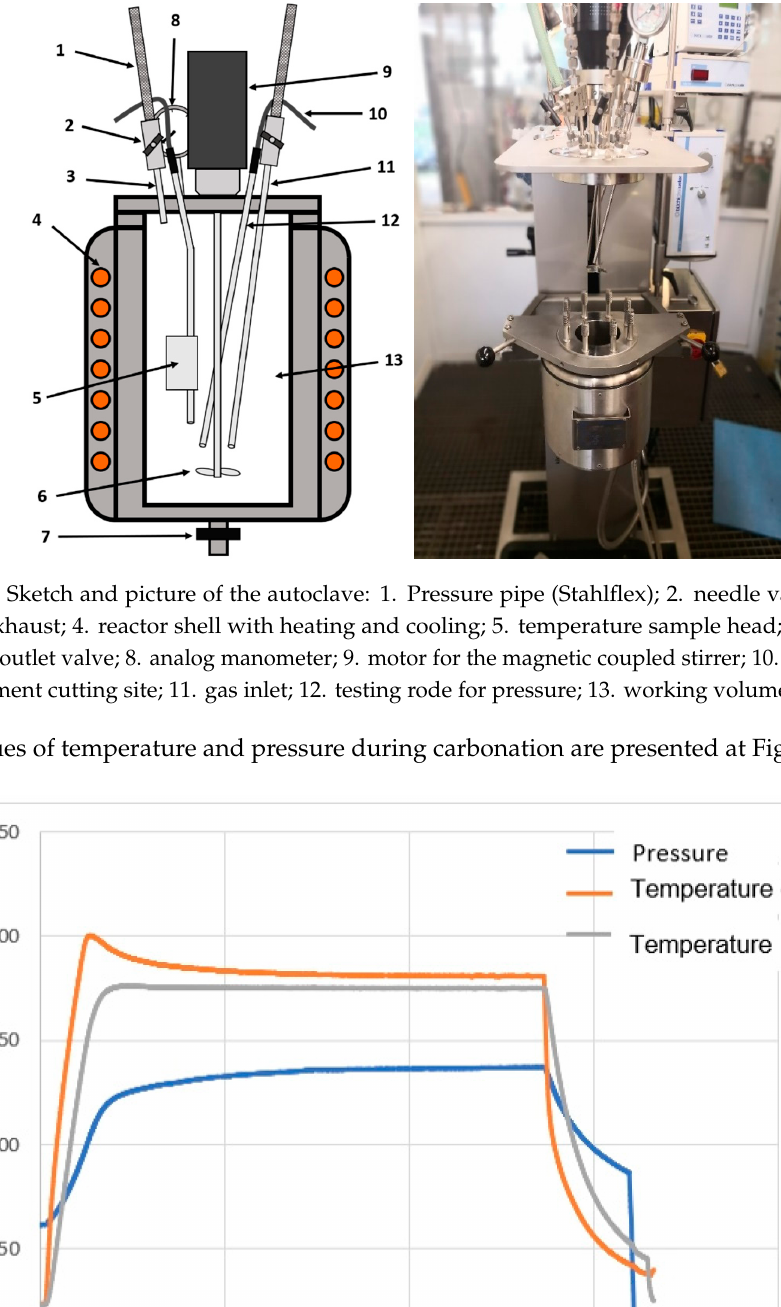
Figure 5. Pressure, temperature and time curves during work in autoclave (R-reaction; A-autoclave) .